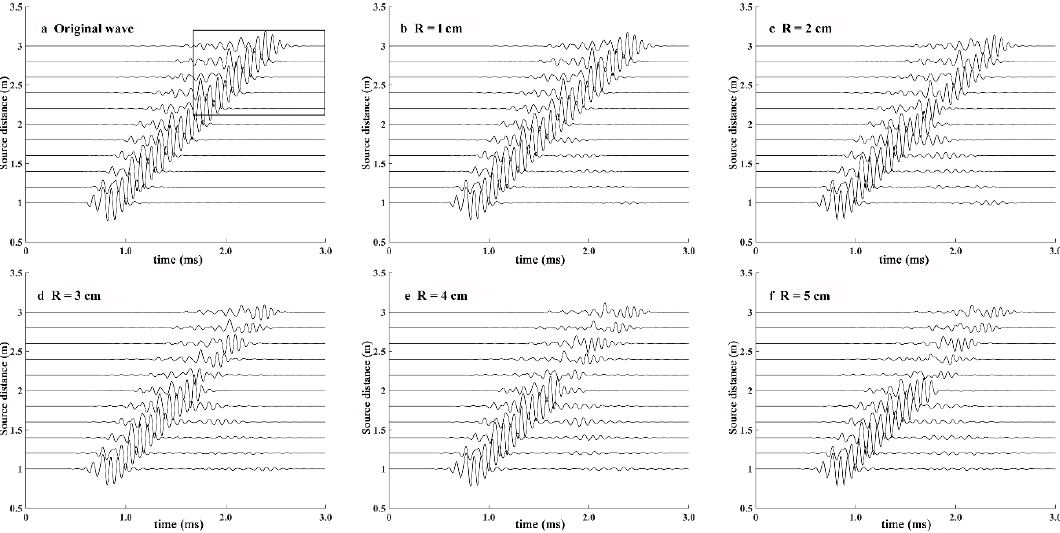
Figure 10. Effect of the radius of the cave on ST wave. ( a) shows the wave train in homogeneous elastic formation. ( b – f) represent the wave train in the formation with cave of different radii. R represents the radius of the cave. The distance of the cave to the borehole wall is 2 cm. Center frequency of source is 10 kHz.